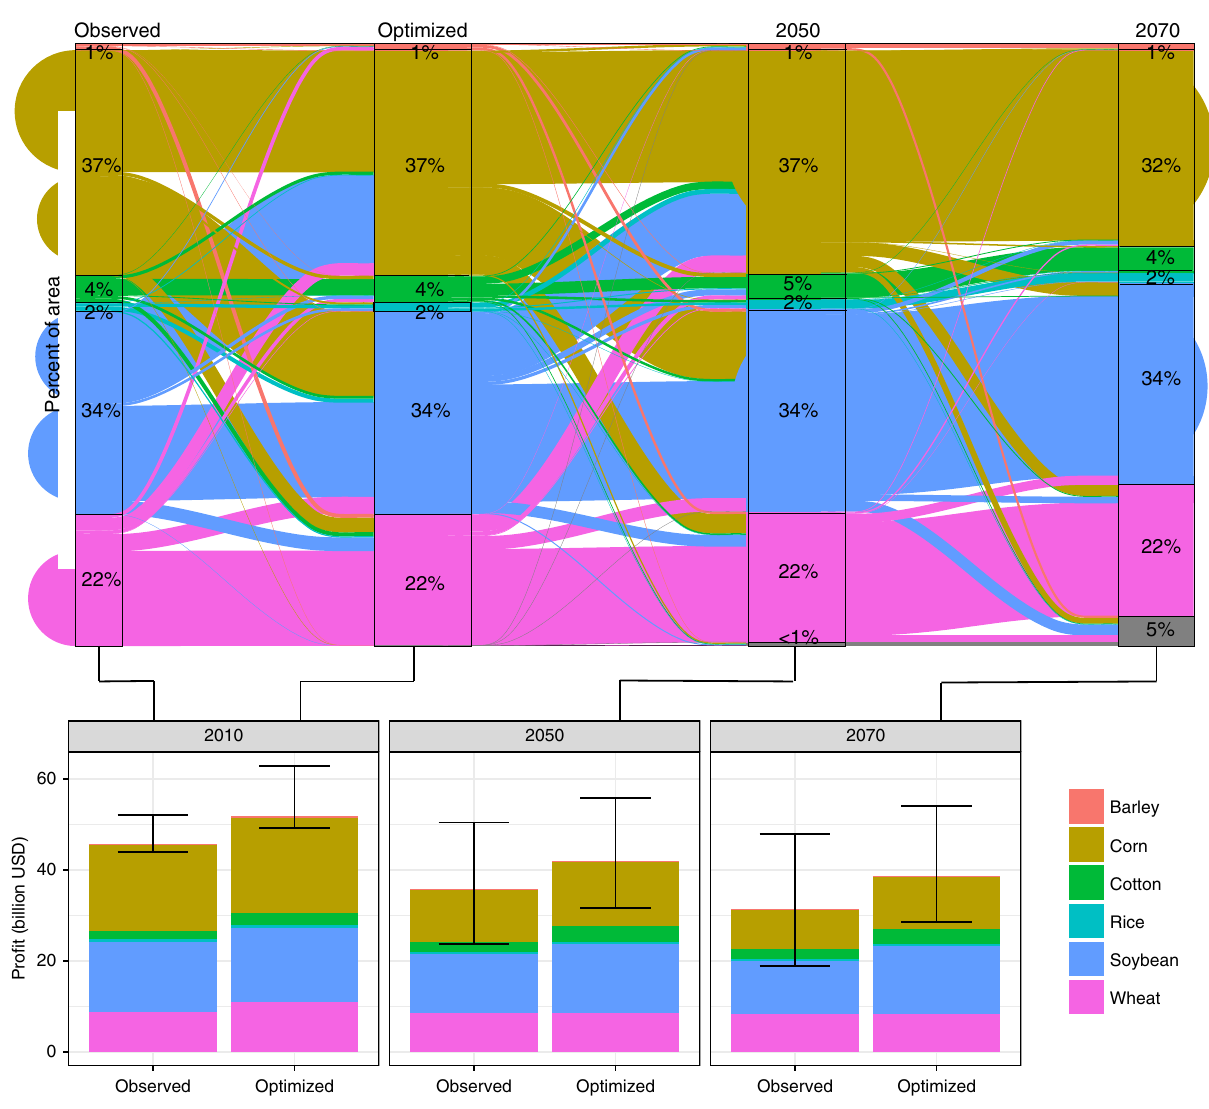
Fig. 3 Adaptation outcomes accounting for crop shifting. (Top) The portion of the area allocated to each crop, under the optimization, in percent labeled boxes. Flows between the allocations show the portion of the area previously allocated to the crop on the left, and fl owing into its new allocation on the right. The difference between observed and optimized crop allocations ( fi rst transition) is due to replacing secondary crops with primary crops. (Bottom) Pro fi ts under observed and optimized crop allocations for the current climate ( fi rst box), 2050, and 2070. The fi rst bar in each column gives estimates of pro fi ts without relocation of crops, and the second bar is with optimization. The bars show mean pro fi ts across posterior draw Monte Carlo optimizations and the error ranges show 95% credible